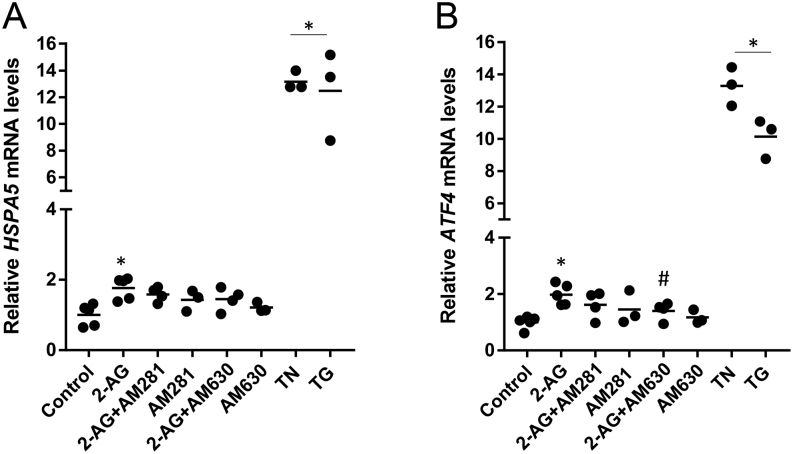
Evaluation of 2-AG effects in ER-stress markers by qRT-PCR analysis. BeWo cells were treated with 2-AG (10 μM) for 24 h. For the assessment of ER-stress dependency on cannabinoid signalling, cells were pre-incubated with the CB1 and CB2 antagonists AM281 and AM630, respectively. (A) 2-AG increased the transcript levels of BiP encoded by the HSPA5 gene in a CB-independent manner. (B) 2-AG increased the transcript levels of ATF4 through CB2 activation. This effect was reversed by the incubation with the antagonist AM630, indicating a CB2-dependency. Tunicamycin (TN) and thapsigargin (TG) were used as ER-stress inducers. Results show transcript levels normalised against GAPDH. Data are presented as the mean ± s.e.m. (*P < 0.05 vs control; #P < 0.05 vs 2-AG).